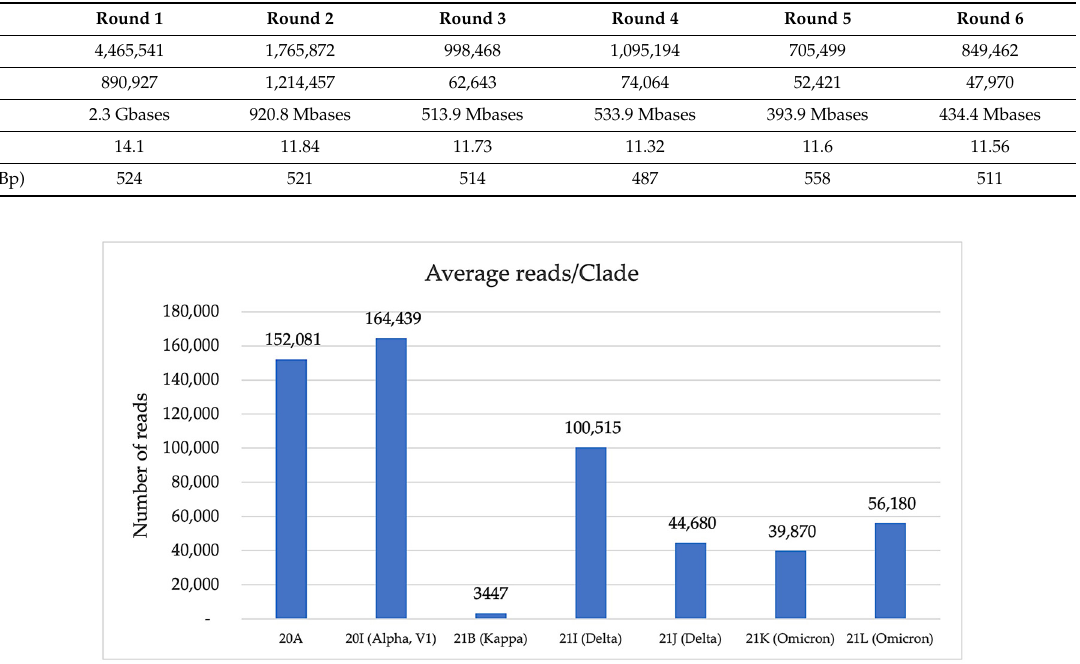
Table 1. Overview of the nanopore indicators obtained.